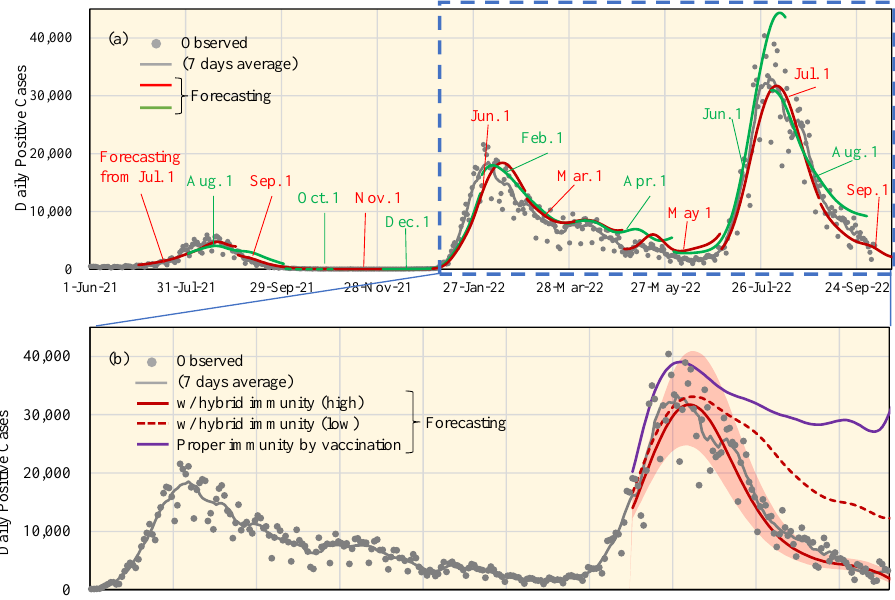
Figure 4. ( a ) Performance of the forecasting system for daily positive cases. In evaluating the performance, Twitter and mobility data were assumed to be known from the reported value. A 2-month forecast was made every month (on the first day of the month). The vaccination effectiveness with hybrid immunity (High), shown in ( b ), was considered. Observed cases and seven-day average values are shown in grey. Red and green curves are used to represent the forecasting to clarify the overlap. ( b ) Time series of forecasting of the daily positive cases in Tokyo from 1 July to 30 September 2022, considering the vaccination and hybrid immunity at the population level. The red colored area indicates the 95% confidence interval of the prediction considering hybrid immunity (High).